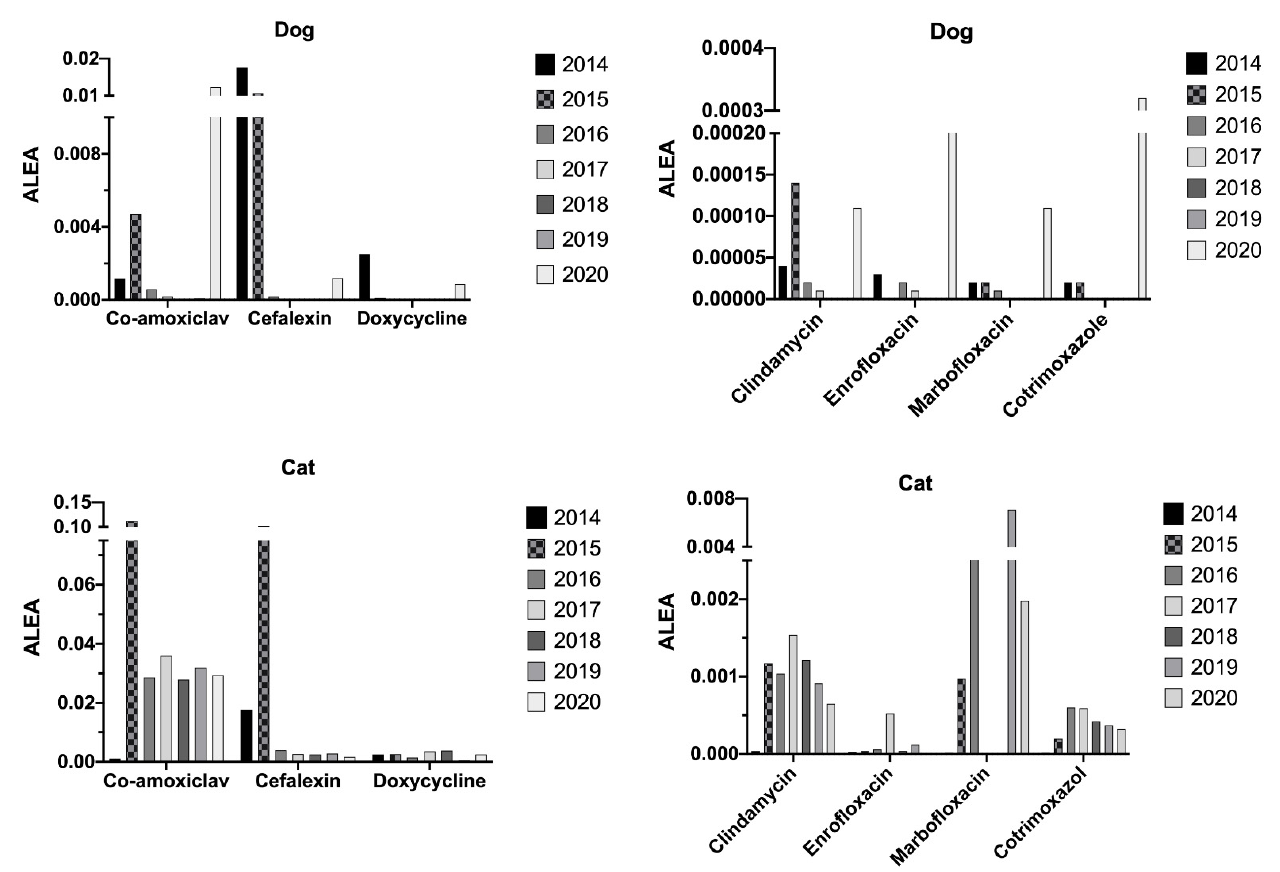
Figure 7. Comparison of the ALEA for dogs and cats by antibiotic molecules from 2014 to 2020.